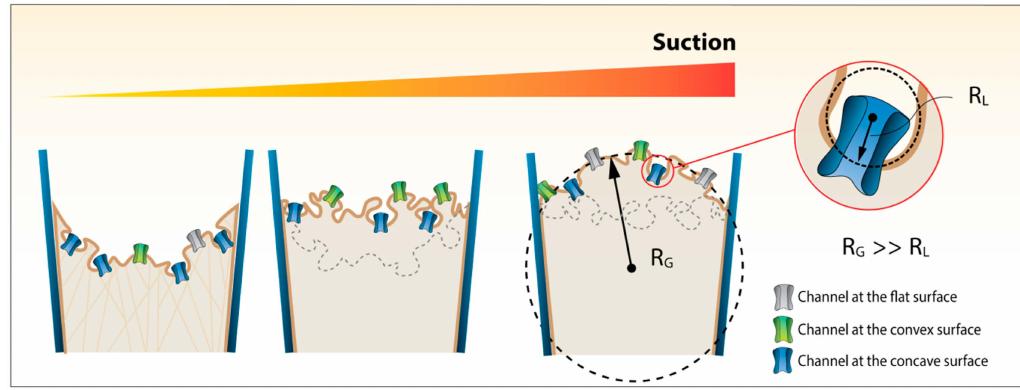
Figure 1. The difference between local and global curvature. Change in global (R G ) and local (R L ) radius of curvature of a membrane patch from a ‘resting state’ to an inflated dome state during applied negative pressure. The regions causing local curvature here in a biological membrane (e.g., caveolae) are of course not seen in a ‘pure’ lipid bilayer. As pressure is applied the regions of high local curvature flatten out. In a cellular environment this flattening of caveolae provides a degree of mechanoprotection by buffering the membrane tension in response to an applied